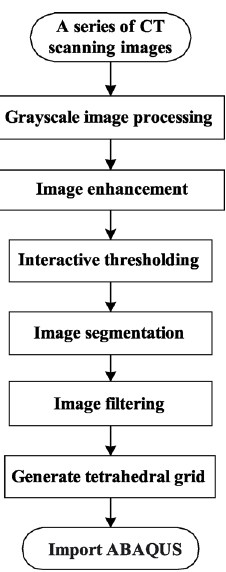
Fig. 2 Schematic of the X-ray CT acquisition process, where the SOD and ODD are 105 and 189 mm, respectively.